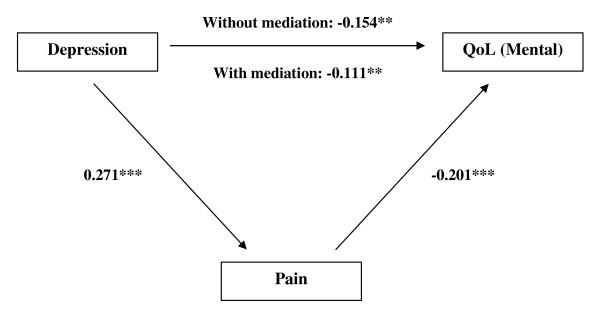
Standardized beta coefficient in pain partially mediated pathway from depression to QoL (mental). ** p < 0.005; *** p < 0.001.